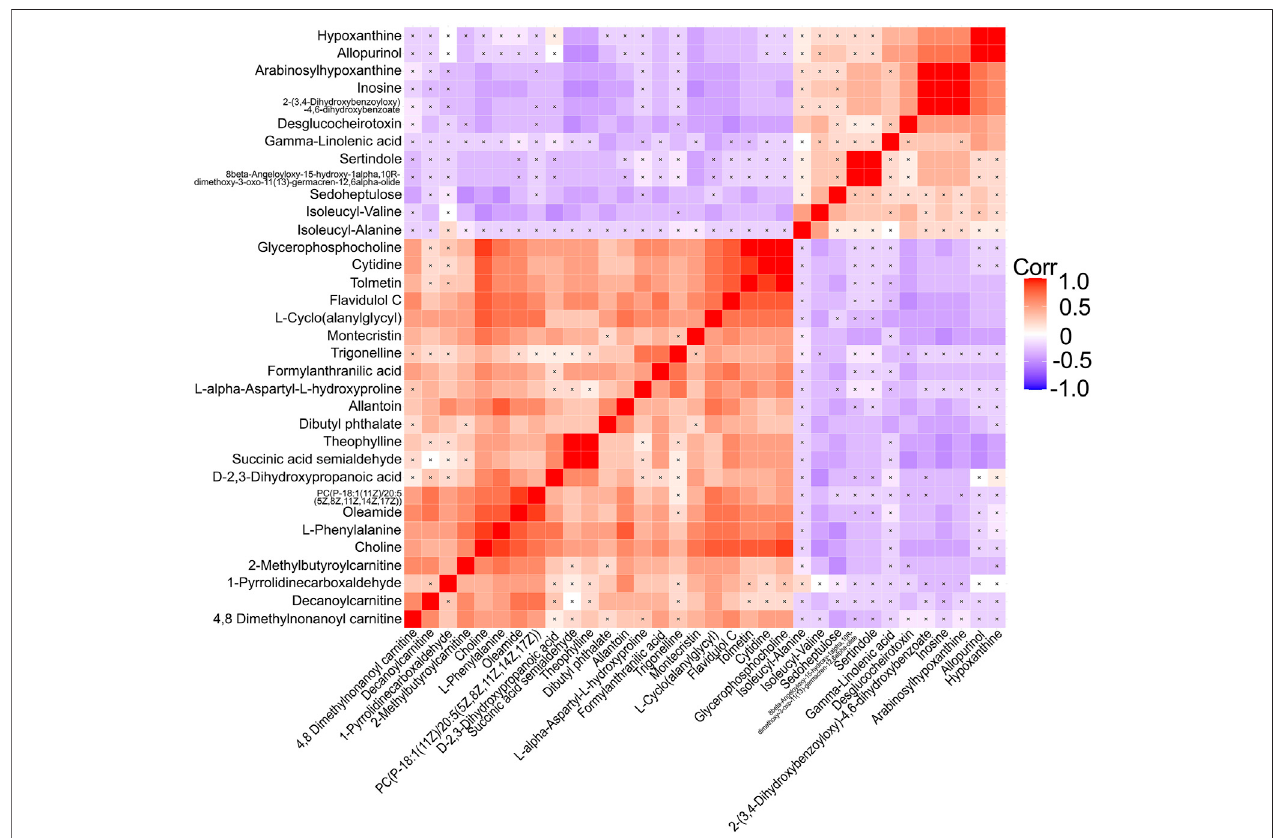
FIGURE 5 | Correlation analyses of differential metabolites between the EA group and the non-EA group. 34 altered metabolites (including 3 metabolites of benzenoids) listed in Table 3 were performed Pearson correlation analyses using a heat map. The positive and negative correlations were shown in red and blue, respectively. A cross mark indicated a nonsigni fi cant correlation.